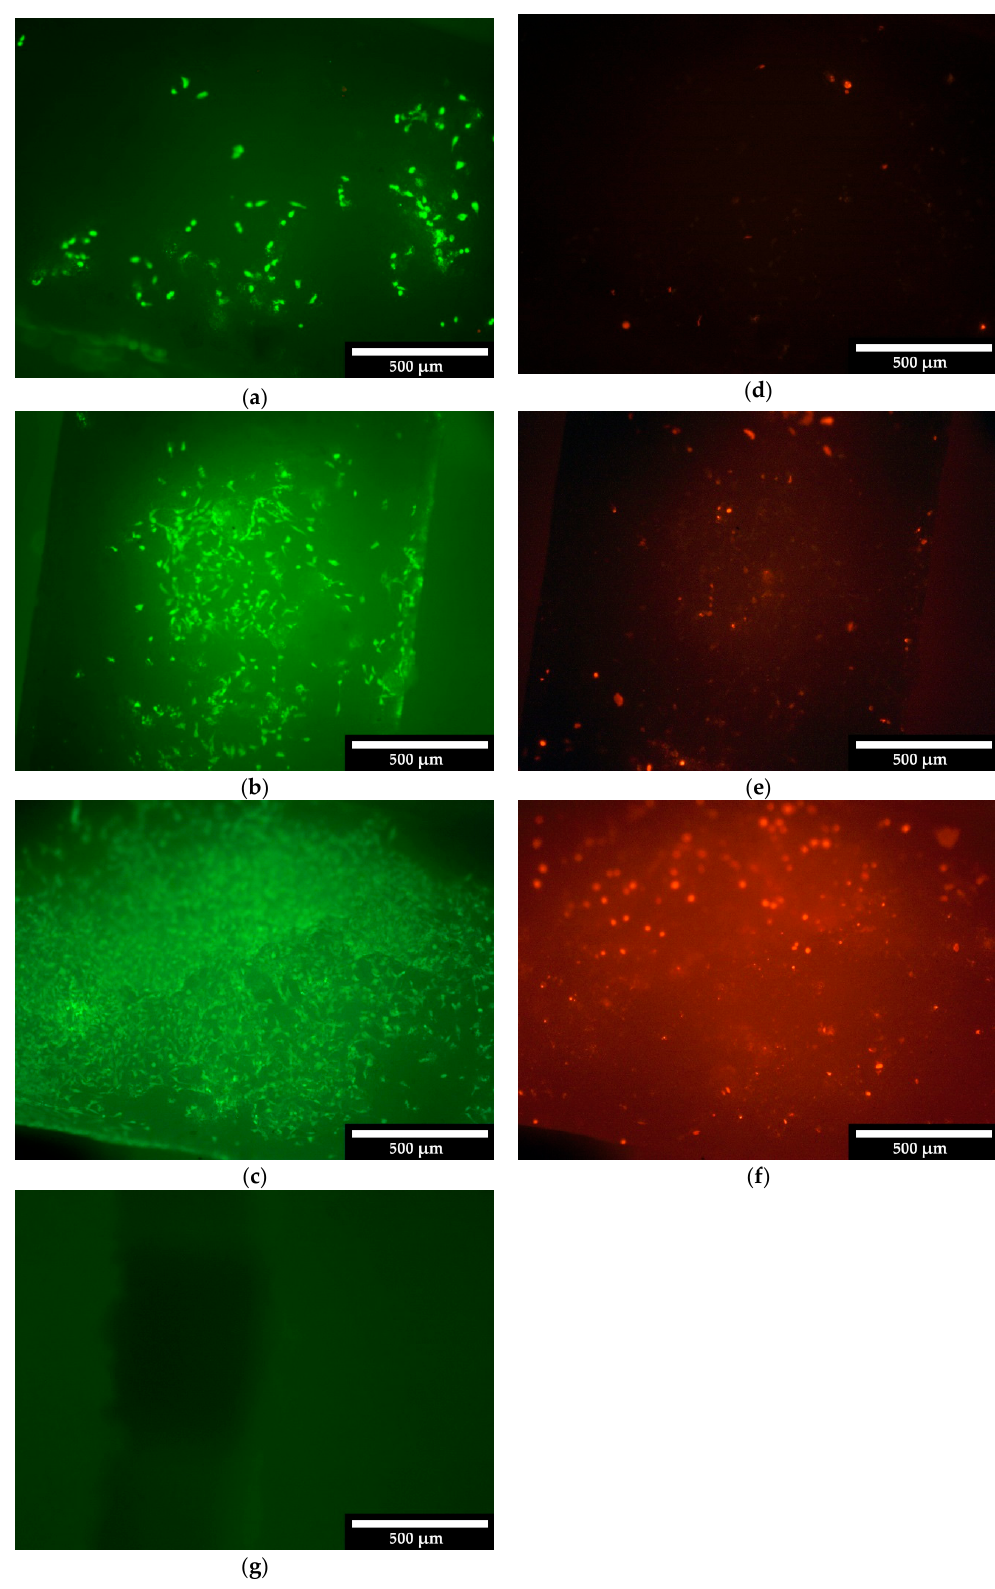
Figure5. Living / deadcellsontheoutersurfaceoftheceramics, 500 µ msca ff oldafterthreedays( a :Living; d : Dead), seven days ( b : Living; e : Dead) and 10 days ( c : Living; f : Dead); g : Auto-fluorescence of the ceramics; white bar = 500 µ